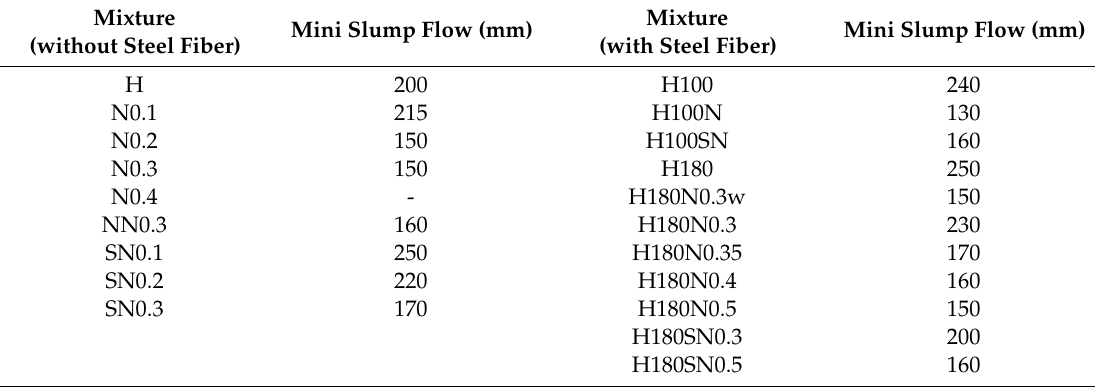
Table 4. Slump flow